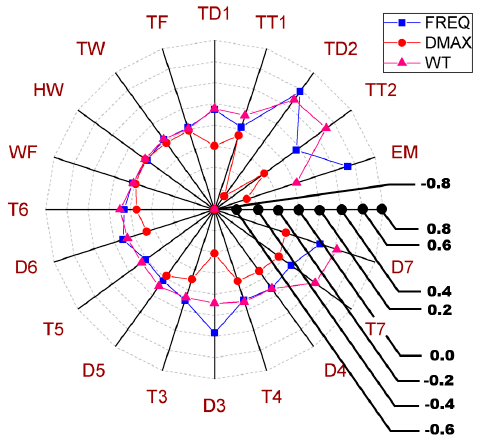
Figure 7. The SRC s between the design variables and the maximum deflection (DMAX), total weight (WT), and frequency (FREQ).